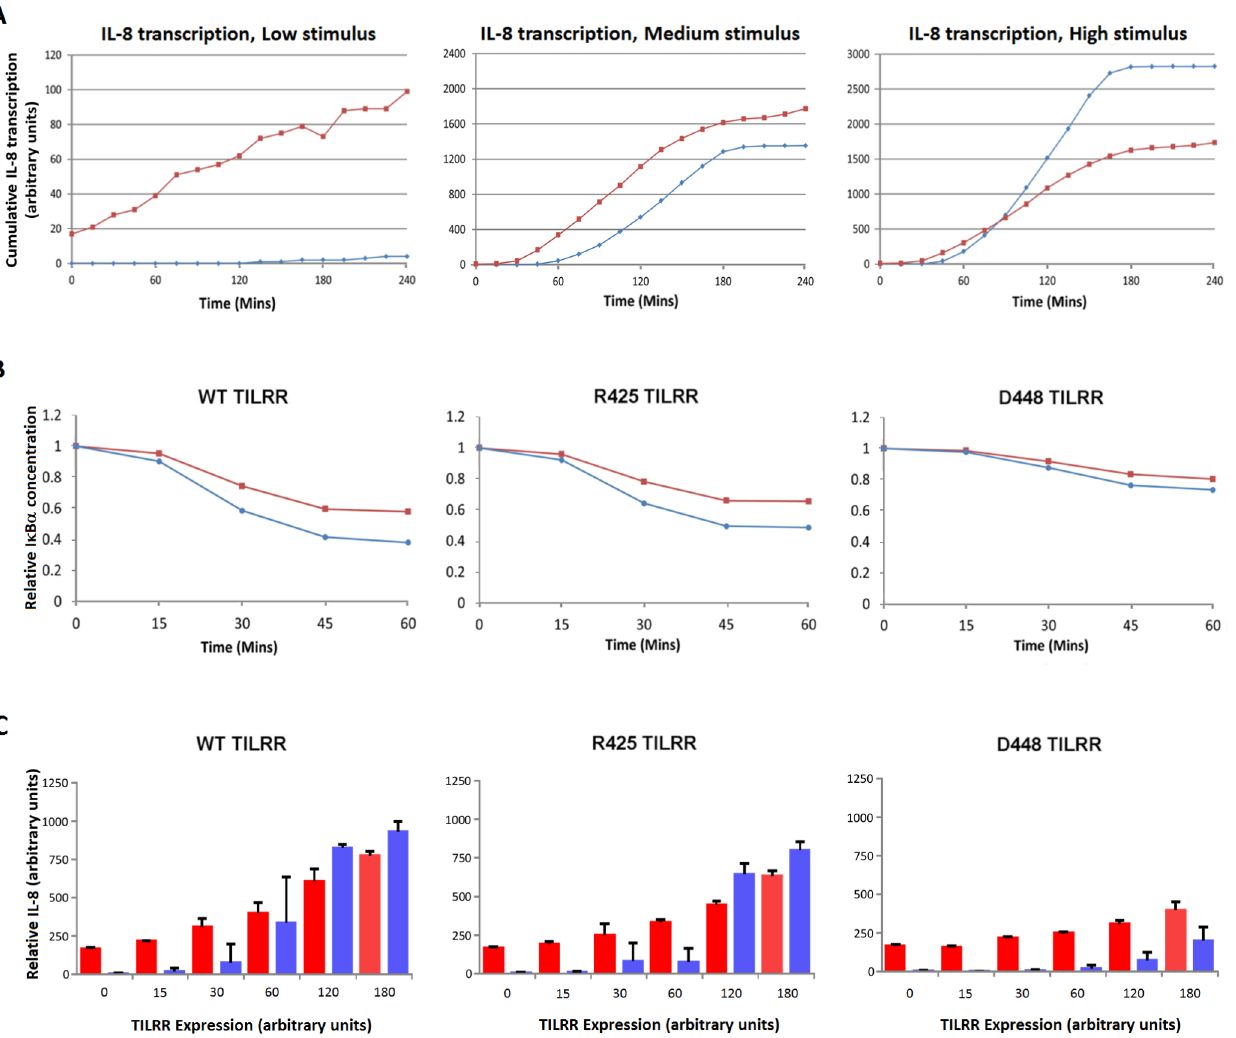
Fig 5. Cytoskeletal binding and release of I κ B α controls NF- κ B signalling and gene induction. A. Simulated IL-8 gene activity kinetics at varying IL-1 pathway stimulation levels, in the presence (Red) and absence (Blue) of cytoskeletal binding and release of I κ B α . Simulations show that disabling cytoskeletal binding of the inhibitor abrogates activation at low levels of stimulation, causes delayed responses at medium stimulation, and results in a slightly delayed but significantly increased activation at high levels of stimulus. P < 0.05 at low and high stimulus. B. Simulated degradation of I κ B α after stimulation with saturated levels of IL-1 β (10 -9 M) with enabled (Red) or disabled (Blue) cytoskeletal binding and release of I κ B α , in the presence WT TILRR, R425 TILRR or D448 TILRR. The model predicts that cytoskeletal binding of I κ B α causes a reduction in its degradation in the presence of WT TILRR and both mutants, consistent with a greater IL-8 response at higher levels of stimulation. The low level of I κ B α -degradation induced in the presence of the 448 mutant is similarly affected by cytoskeletal binding of the inhibitor. n = 4 p > 0.05 at 60 min for all conditions. C. Predicted IL-8 activity at varying TILRR expression levels, with enabled (Red) or disabled (Blue) cytoskeleton: I κ B α binding, and in the presence of WT TILRR, or TILRR mutants R425 or D448. As expected, inflammatory activity is higher in the presence of wild type TILRR or the 425 mutant. Comparing activity in the presence and absence of cytoskeletal binding, under these conditions, show a more pronounced effect at lower levels with inverse effects at higher levels of, activity, while effects at intermediate activities are less pronounced consistent with data in 5A. Levels in the presence of the 448 mutants correspond to the lower range of activity, only. (Mean ± SEM, n = 3). WT, 425 0.0005 < p < 0.05 at expression levels 0, 15, 120, 180, ns 30, 60. D448. 0.0005 < p < 0.05 at expression levels 0 – 180.